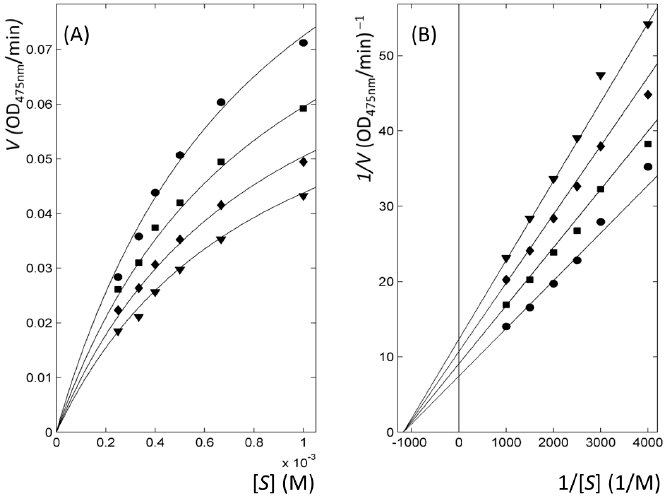
Figure 3. Representative kinetics of enzyme inhibition with thioacetazone. ( A ) Michaelis–Menten; and ( B ) Lineweaver–Burk plots. The lines with ▼ , (cid:31), ■ and ● symbols correspond to the profiles at the inhibitor concentrations of 5, 10, 15, and 20 μ M, respectively.